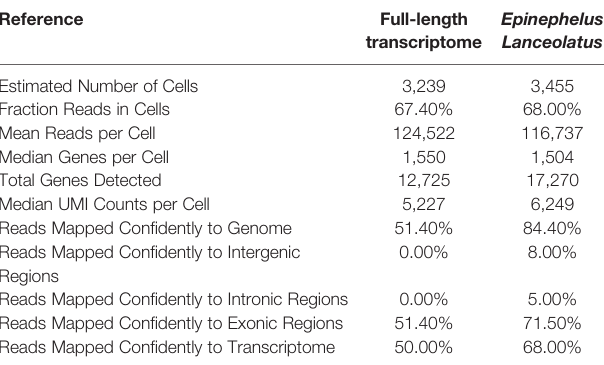
TABLE 2 | Data utilization comparison between different